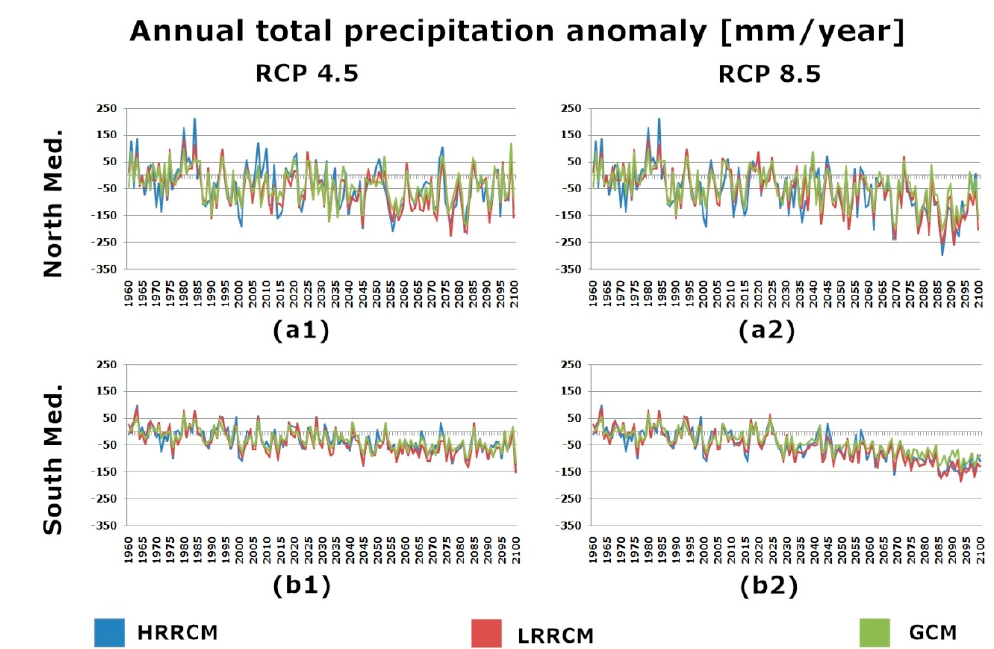
Figure 3. Time series of annual cumulative precipitation anomaly (mm / year) for the period 1960–2100, forRCP4.5(panels( a1 , b1 ))andRCP8.5(panels( a2 , b2 ))scenarios, forthethreeconsideredhorizontalgrid resolutions (HRRCM, LRRCM and GCM) distinguished by blue, red and green colors. Values represent spatially averages over the two analyzed sub-areas (North and South Mediterranean) and are anomalies with respect to the 1961–1990 mean). ( a1 , a2 ), North Med. sub-area; ( b1 , b2 ), South Med. Sub-area.